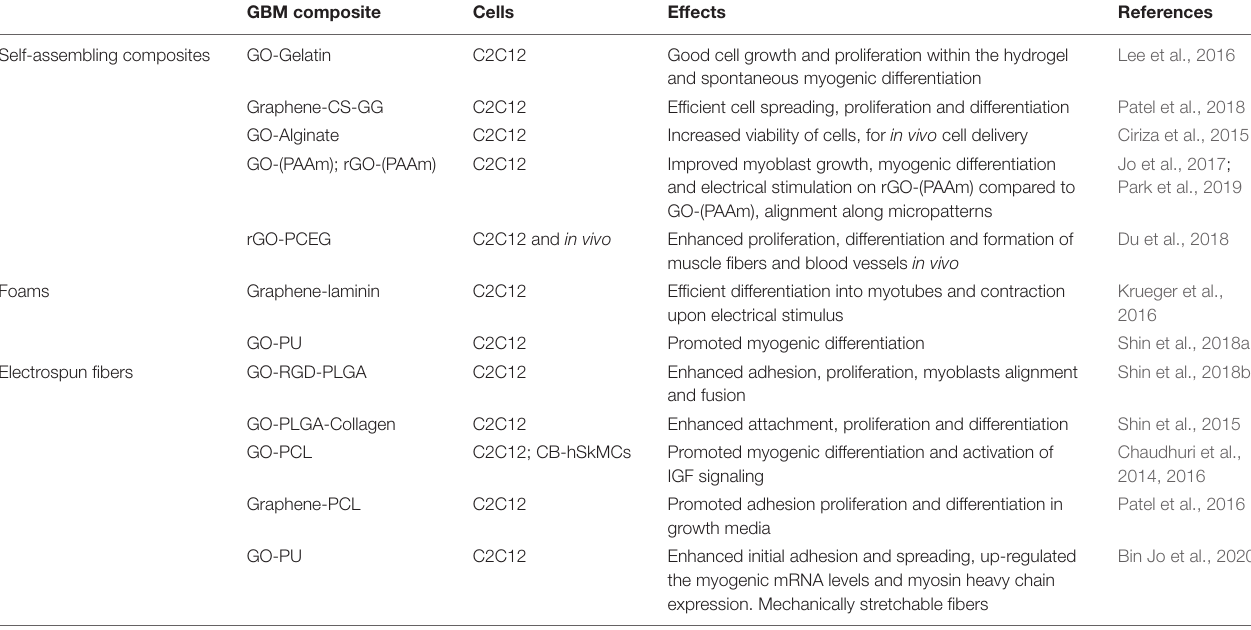
TABLE 1 | 3D graphene scaffolds for myoblasts growth and